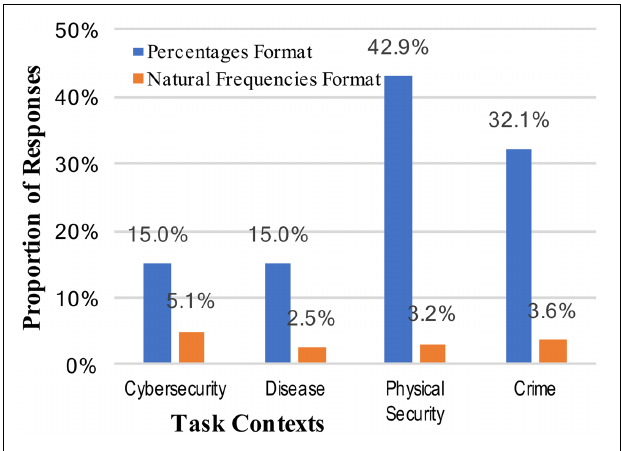
FIGURE 2 | Percentages of participants who incorrectly answered the Bayesian reasoning task with the base-rate (conservatism), across the context stories and numerical format